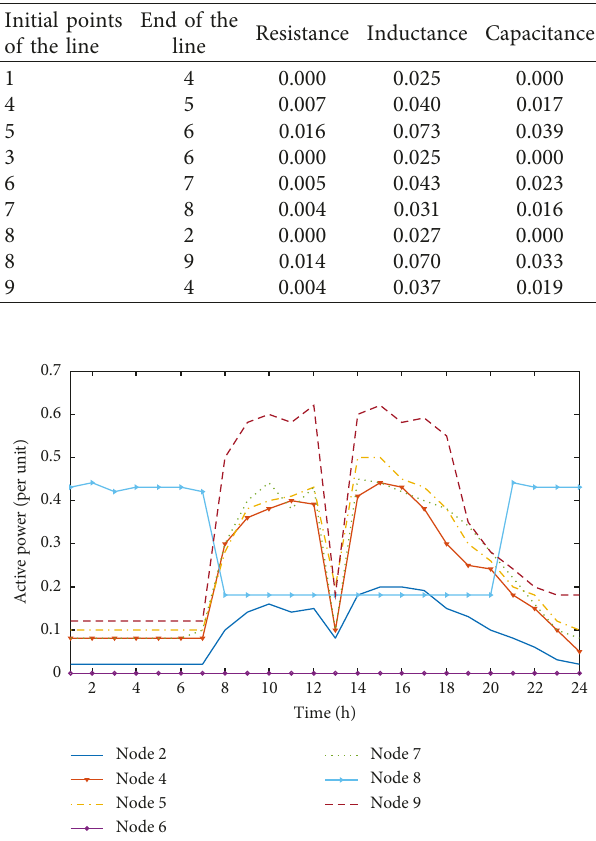
Figure 4: Active power data of the load at each node.